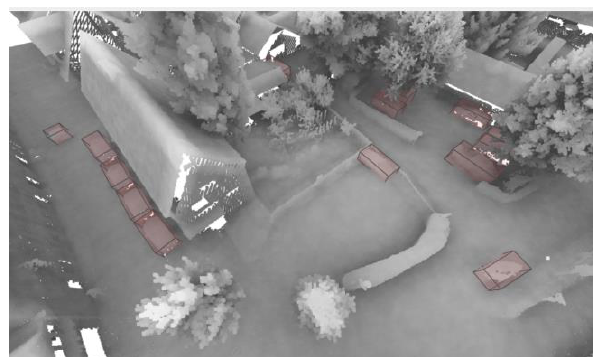
Figure 12. Result of crowd-based vehicle collection projected into the original point